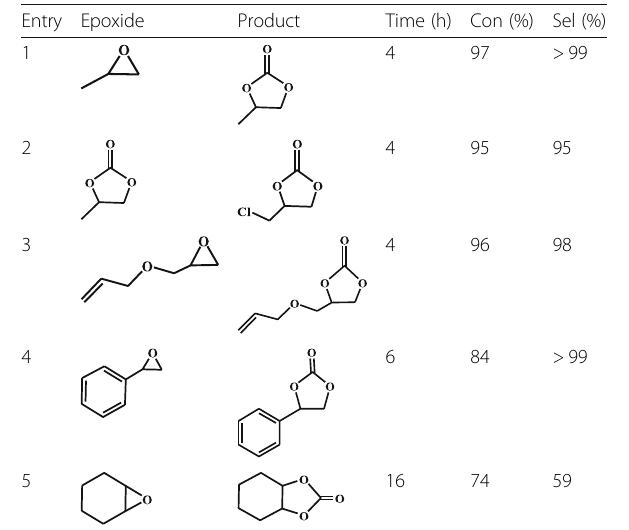
Table 2 Cycloaddition of CO 2 to different epoxides catalyzed by